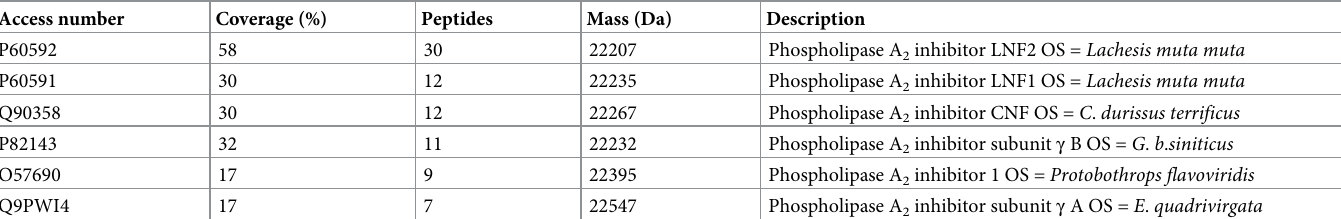
Table 2. Coverage of the peptides from Boa γ PLI. Identification of the proteins with a higher coverage from the peptides obtained from SDS-PAGE band excised and analyzed by mass spectrometry. Access